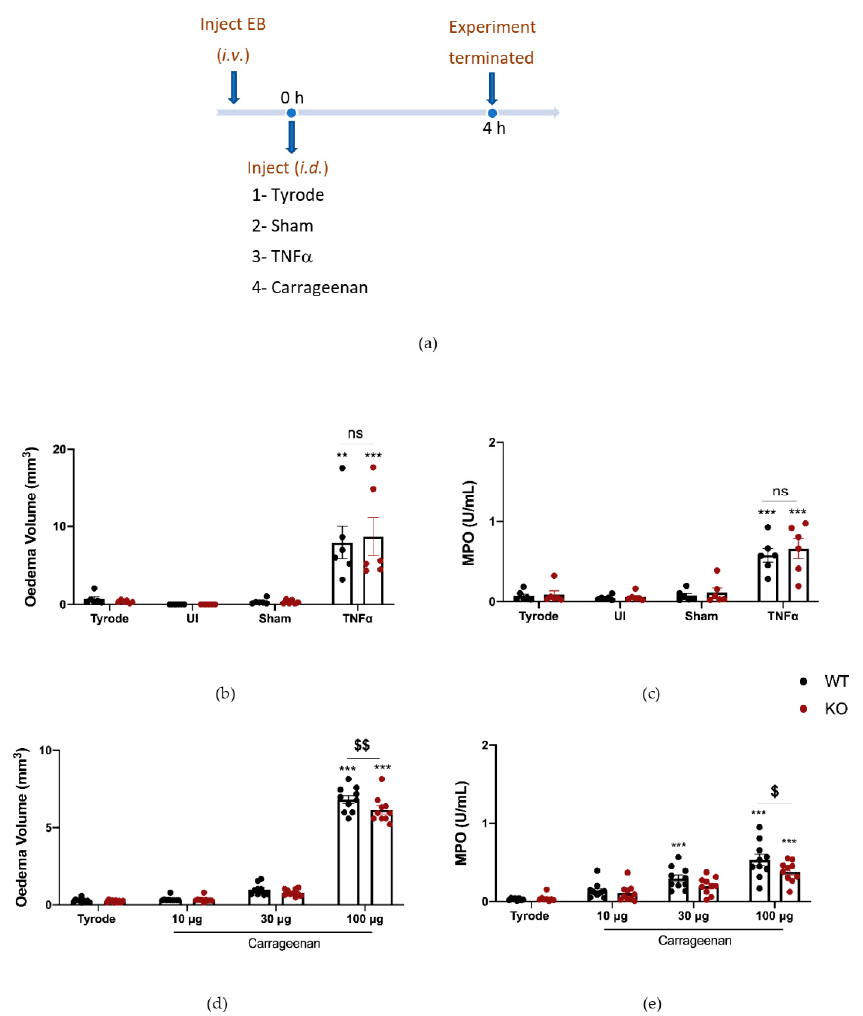
Figure 6. Oedema formation and neutrophil accumulation induced by carrageenan over 4 h is reduced in α CGRPKO mice. ( a ) Timeline for studying tumour necrosis factor alpha (TNF α ) and carrageenan-induced inflammation over 4 h in WT and α CGRPKO mice. Oedema volume ( b ) and neutrophil accumulation ( c ) measured 4 h after injecting TNF α (100 ng/50 µ L i.d.). Results are shown as mean ± SEM ( n = 6). ( d ) Oedema volume and ( e ) neutrophil accumulation measured 4 h after injecting carrageenan (10, 30 and 100 µ g/50 µ L i.d.) in WT or α CGRPKO mice. Results are shown